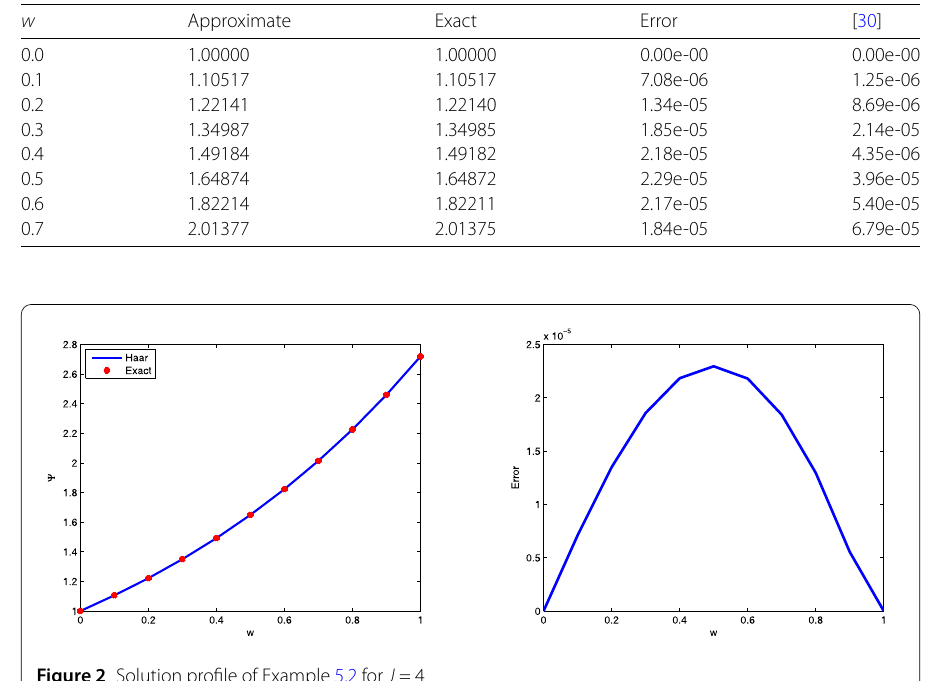
Figure 2 Solution profile of Example 5.2 for J = 4